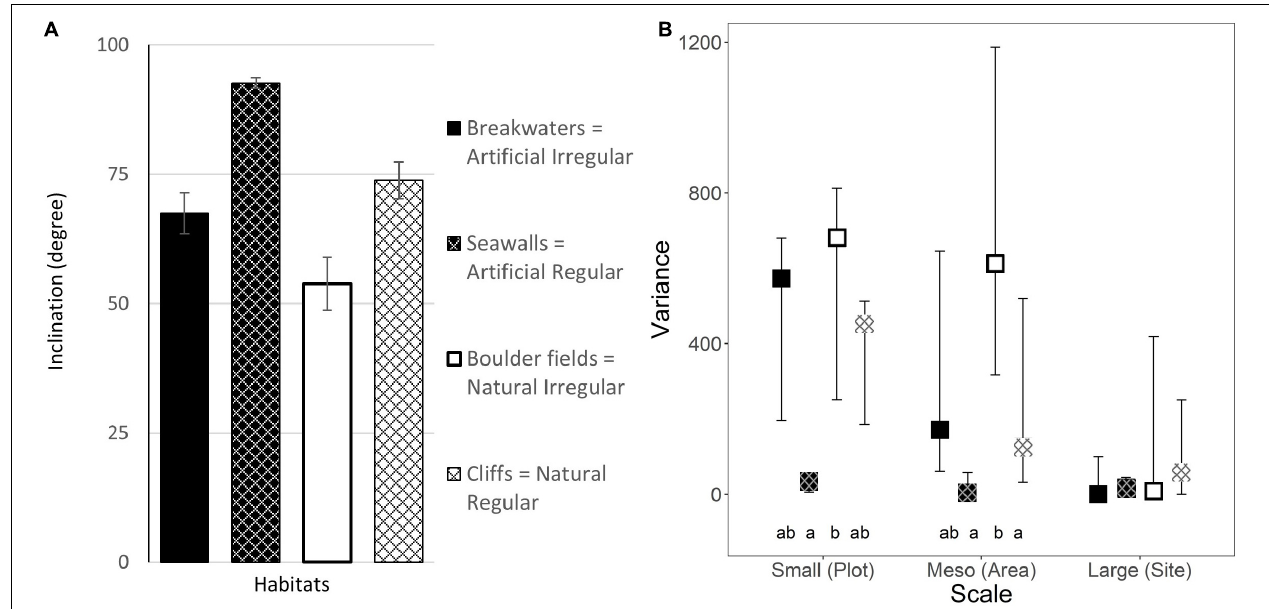
FIGURE 2 | (A) Mean inclination ( ± 1 SE; data are averages of 4 plots at each of 4 areas at each of 3 sites, n = 48) and (B) estimated variance in inclination ( ± 95% CI from bootstrapping) at each scale for the four combinations of habitat Types and Morphologies. Letters indicate significant differences from pairwise-tests ( Supplementary Table 2 ). TABLE 1 | Four-way PERMANOVA results testing the effects on inclination, exposure, roughness, and diversity of morphological microelements. Inclination Exposure Source df MS Pseudo-F p -value Pseudo-F p